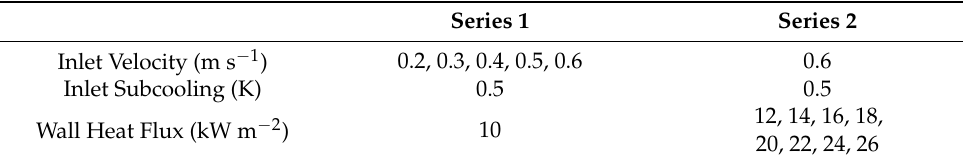
Table 4. Operating conditions for model validation.